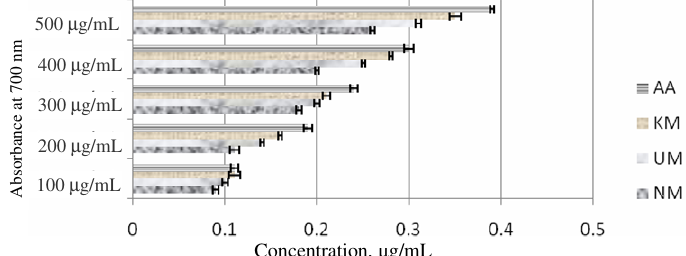
Figure 3. Reducing power of NM, UM and KM compared to ascorbic acid (Values are mean ± SD of five determinations; AA=Ascorbic acid)